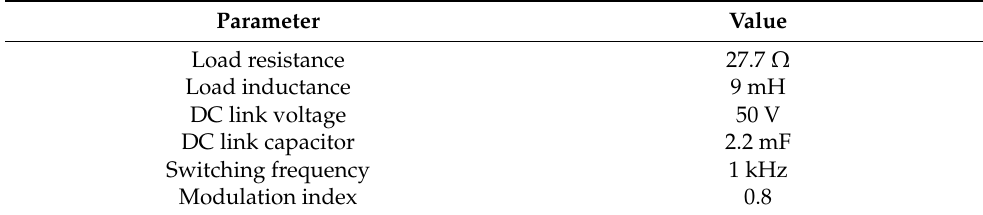
Table 5. Simulation parameters associated with their